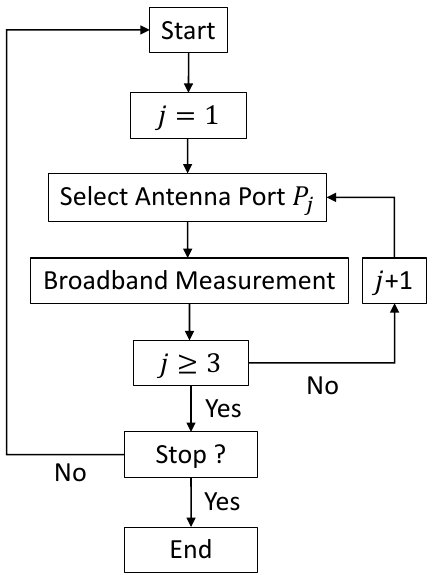
Figure 2. Flow chart of the measurement